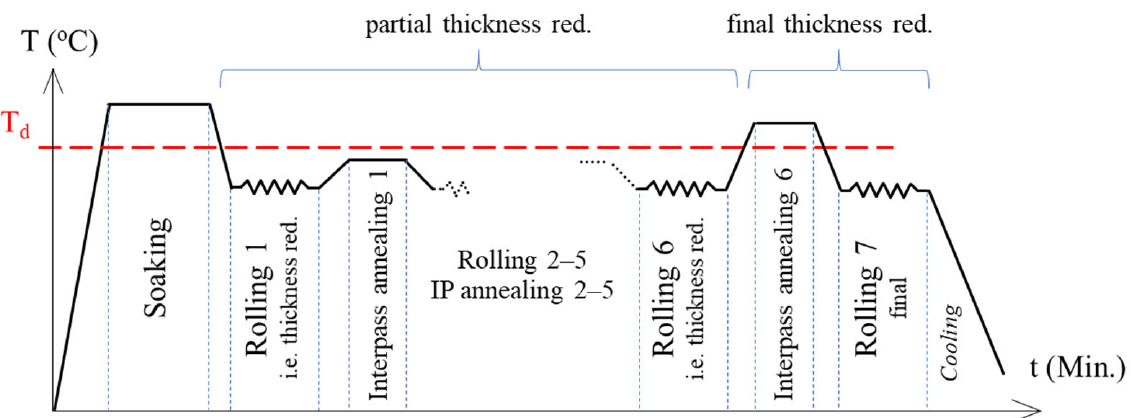
Figure 1. Schematic representation of the soaking, rolling, and cooling procedure applied to the HiperFer trial steels ( T d indicates the dissolution temperature of the Laves phase precipitates).